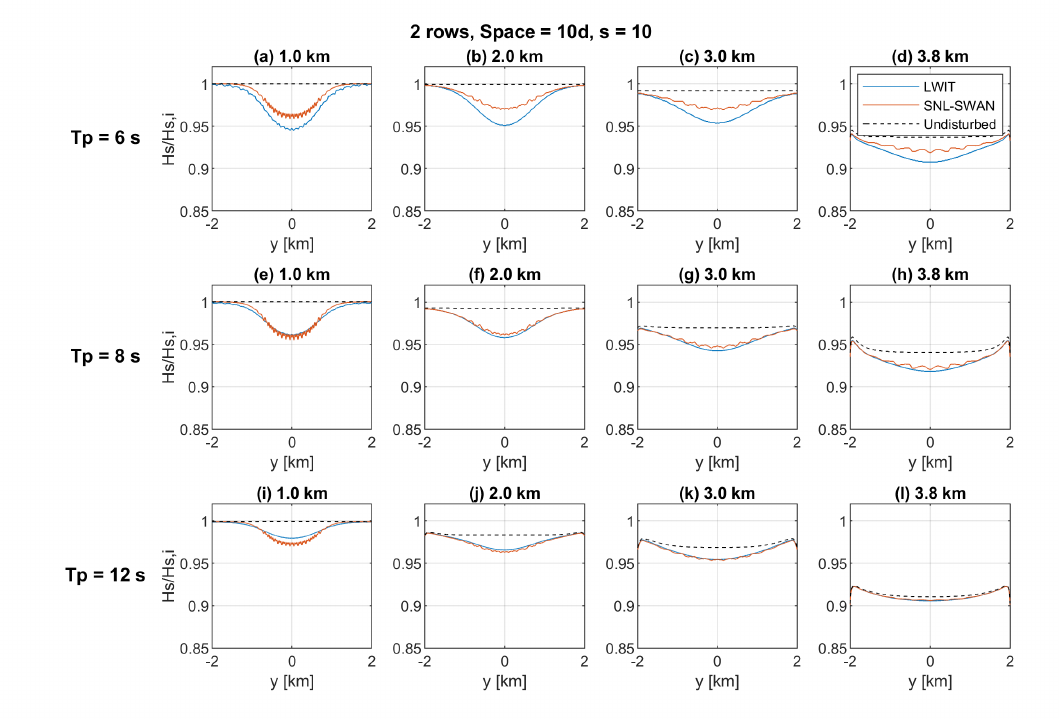
Figure 9. Longshore transects of ˆ H s at various cross-shore locations for the conditions given in Figure